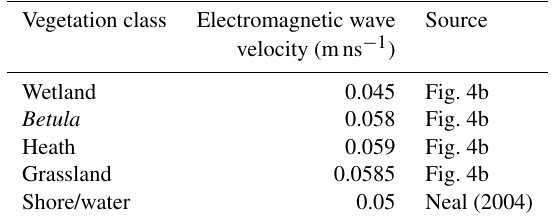
Table 2. Summary of the results from the velocity analysis in Fig. 4. Vegetation